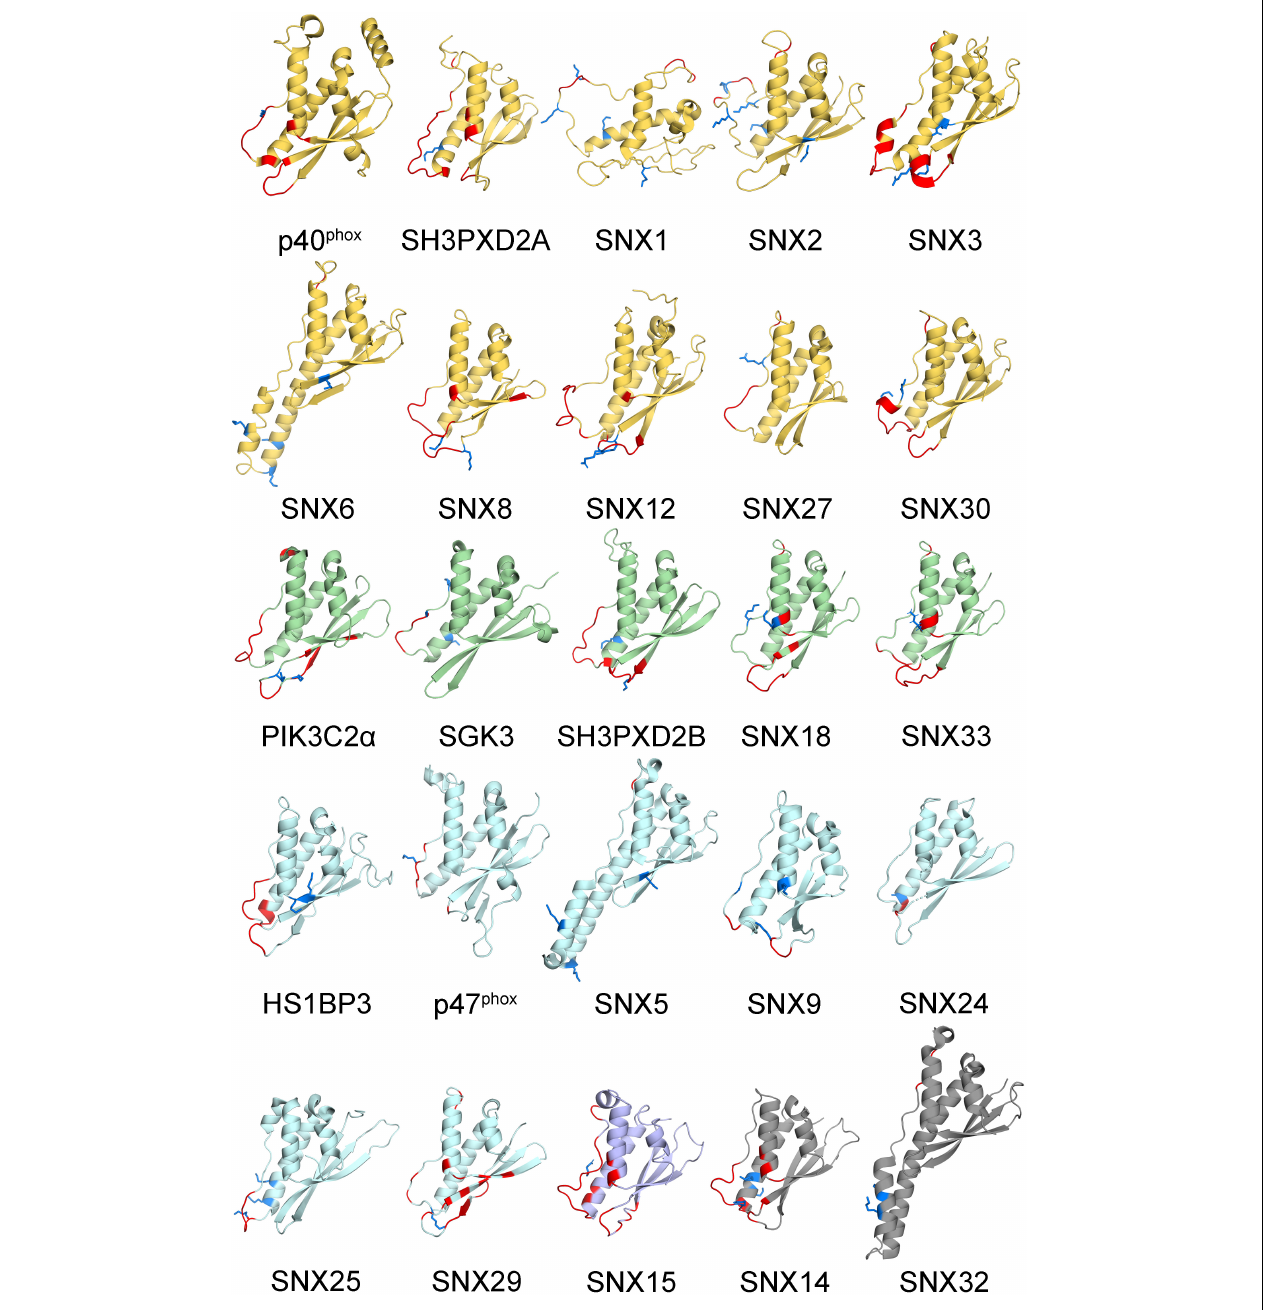
FIGURE 2 | Human PX domain structures with MET-stops. Metabolite-modified Arg and Lys residues are shown with sidechains in blue. Membrane docking residues with MODA scores greater than 30 are shown in red. Backbone ribbon colors correspond to the specificity indices of 10 (yellow), 8–9 (green), 5–7 (light blue), 1–4 (purple), and non-binding